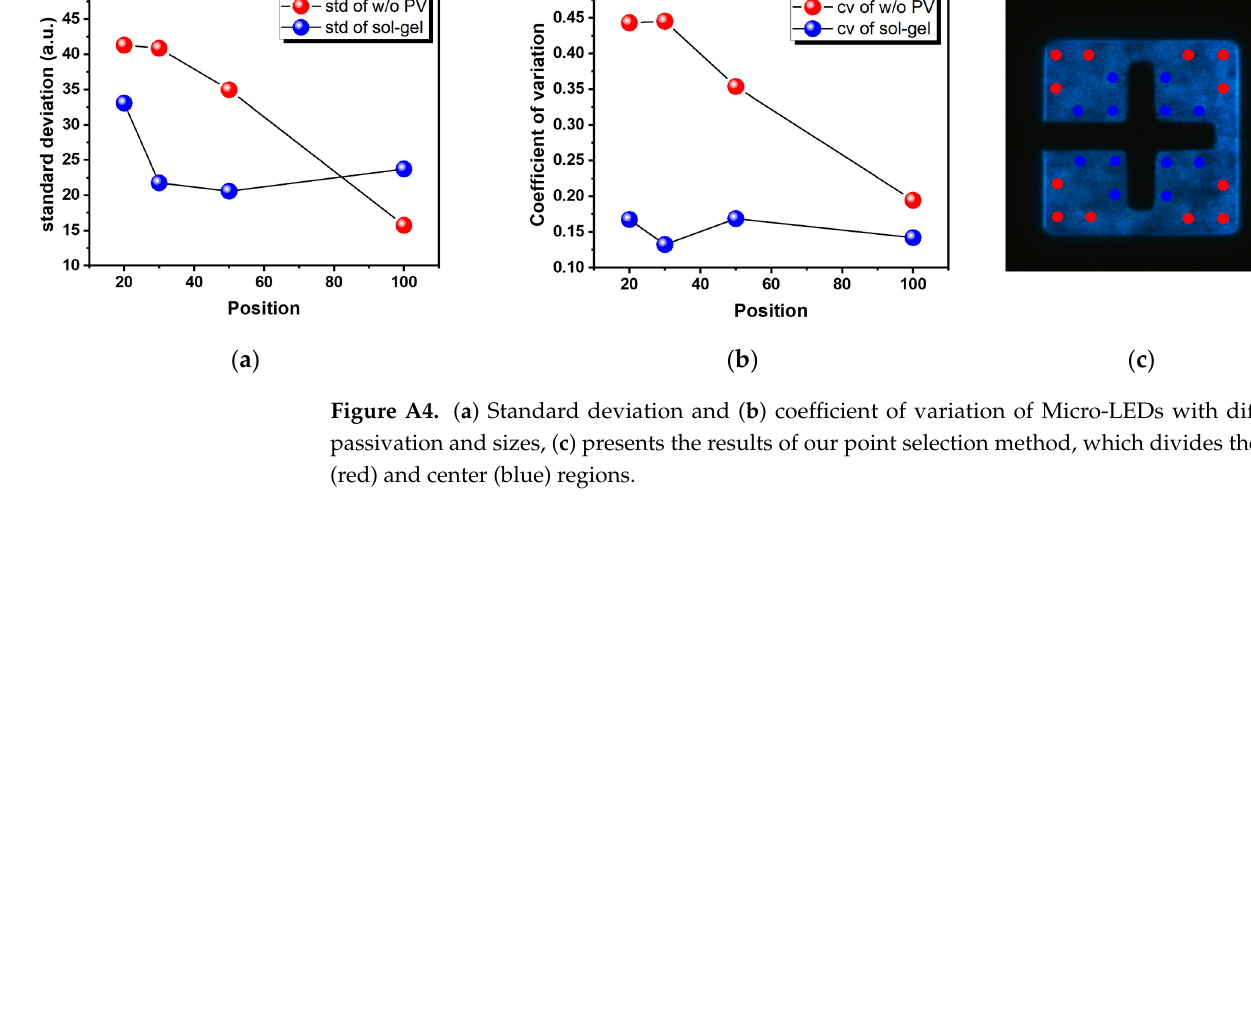
( c ) Figure A5. EQE and WPE curves of Micro-LEDs of S1, S2, and S3 for ( a ) 30 × 30 μ m and ( b ) 60 × 60 μ m; ( c ) 100 × 100 μ m. References 1.